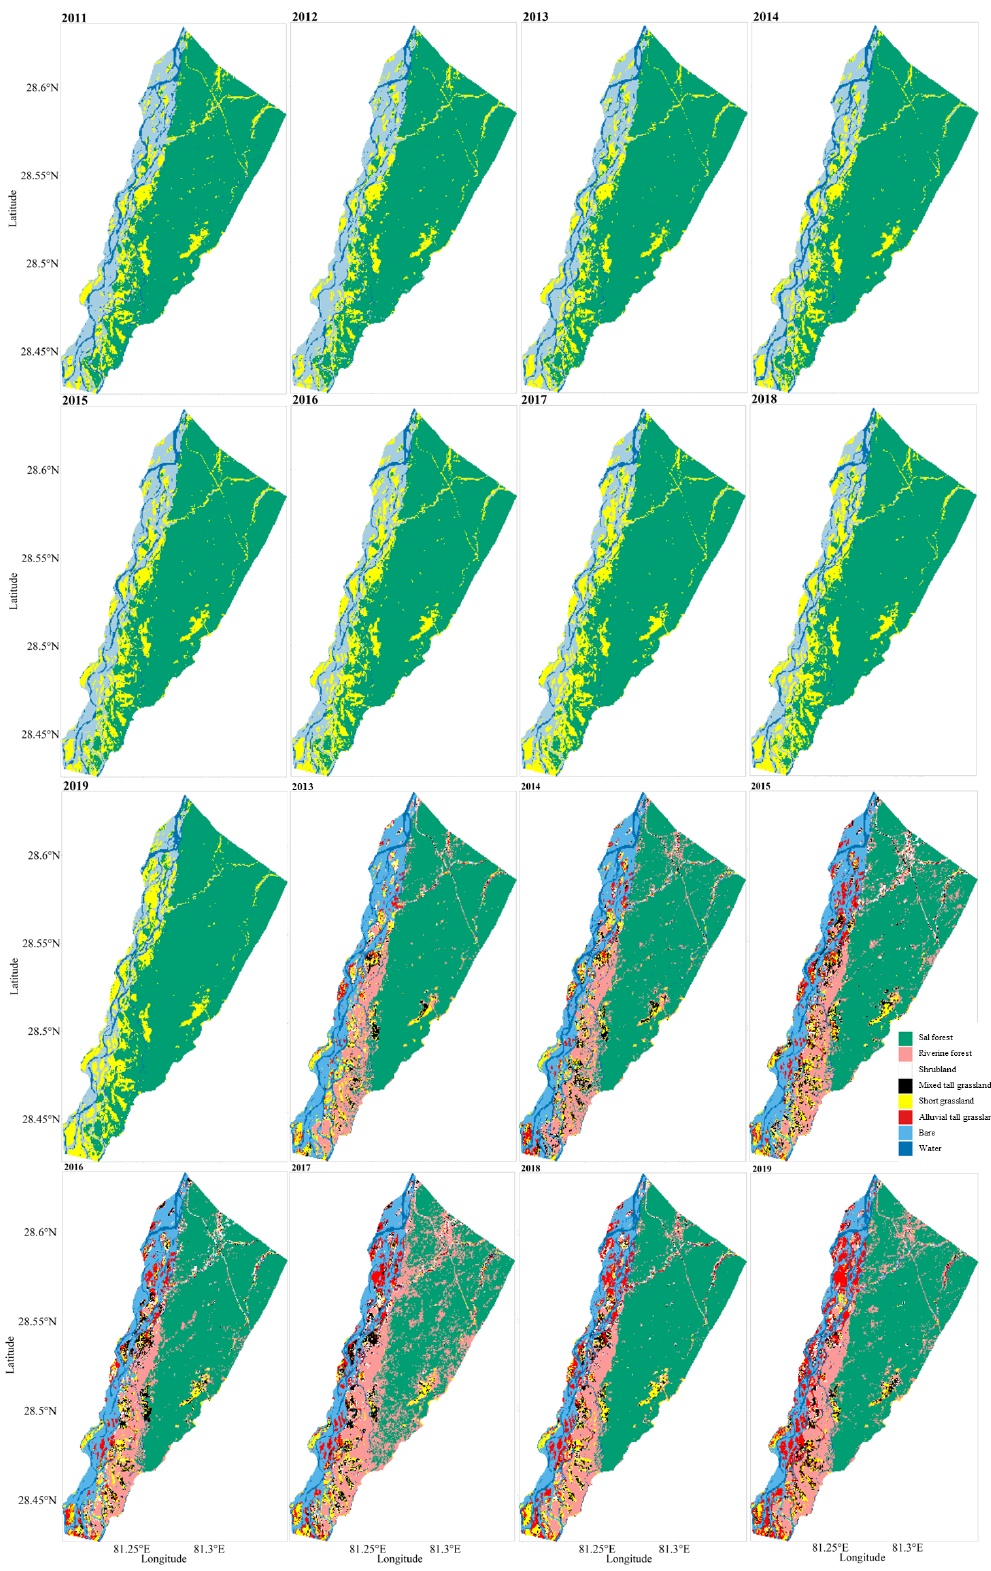
Figure A3. Land cover maps of the level 1 and level 2